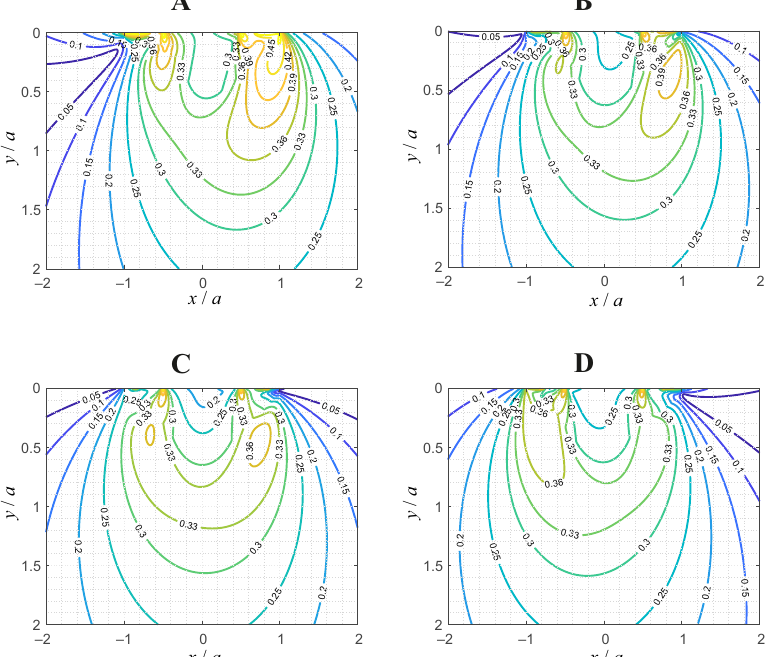
Figure 6. Contour line diagram of the maximum shear stress, normalized for the average contact pressure P / ( 2 a ) , in the oscillating tangential contact with a truncated cylinder, as a function of x / a and y / a , for b = 0.5 a , Q max = 0.6 µ P , µ = 0.5 and ν = 0.3; for the points ( A ), ( B ), ( C ), and ( D ) of the loading diagram in Figure 4 (each subfigure corresponds to the respective point in the loading